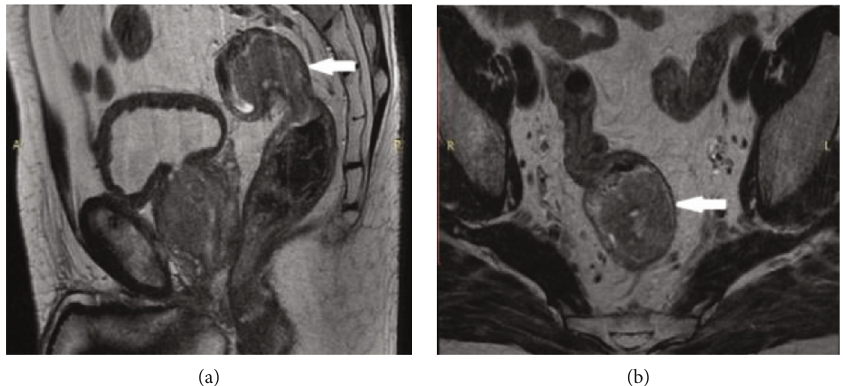
Figure 1: Sagittal (a) and axial (b) reconstruction of a T2-weighted MRI showing the rectal tumor (arrow).